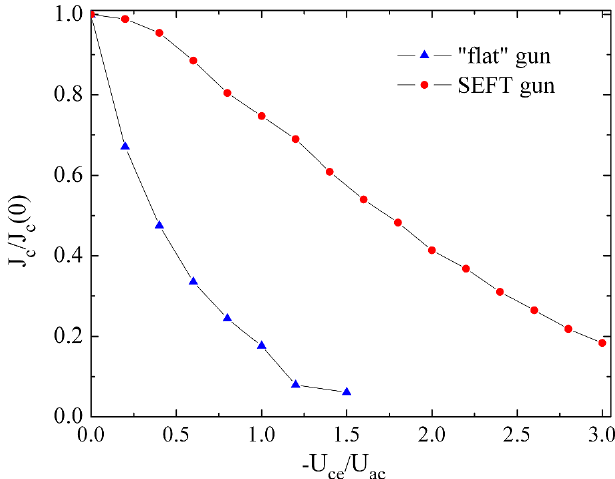
on the near-cathode electrode. pr ¼ 3 kV and the magnetic field in ac